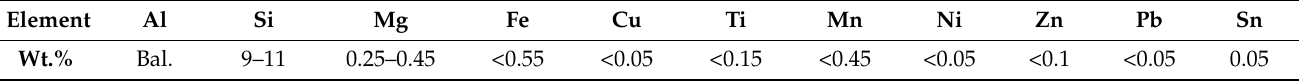
Table 1. Nominal composition of AlSi10Mg, Data from